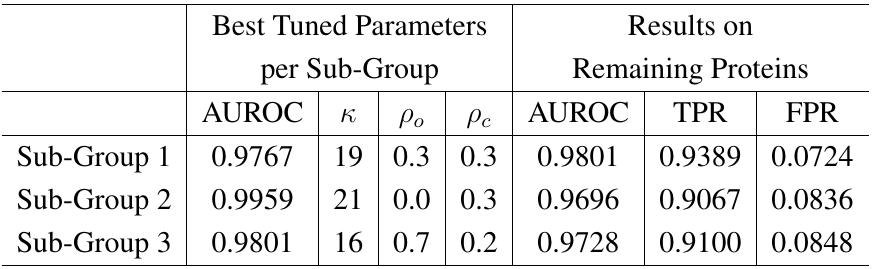
Table 2. Parameters κ , ρ and ρ were tuned to give the best possible AUROC for three o c randomly selected sub-groups of Proteus300. The results of using these parameters on the remaining, disjoint set of proteins are listed in the last three columns. TPR, true positive rate; FPR, false positive rate.